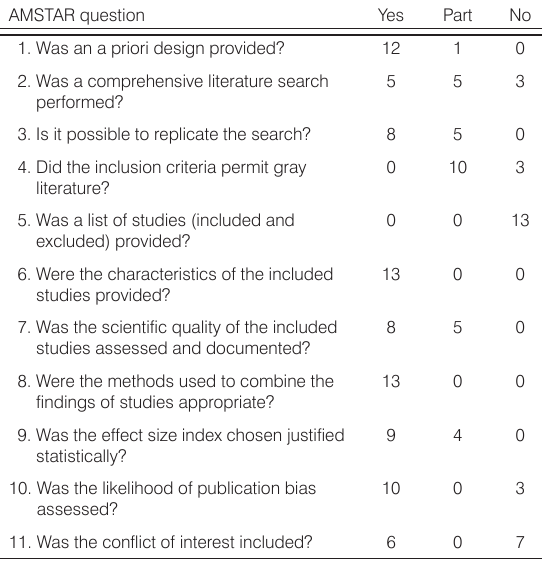
Table 2. Quality of meta-analyses and systematic